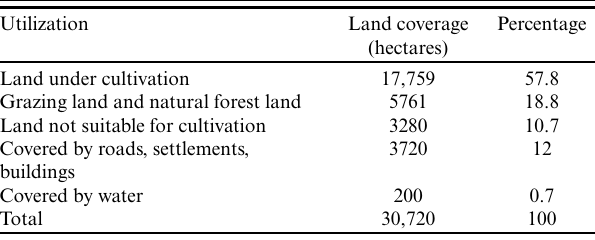
Table 2 . Land utilization in the study